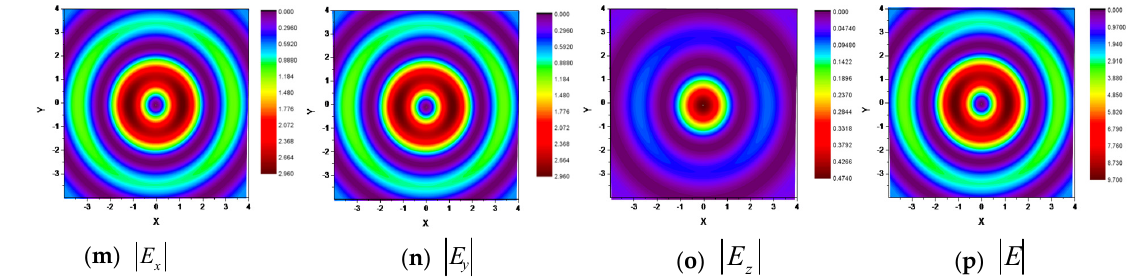
Figure 2. Illustration of the electric components of arbitrarily polarized HOBB. ( a – d )